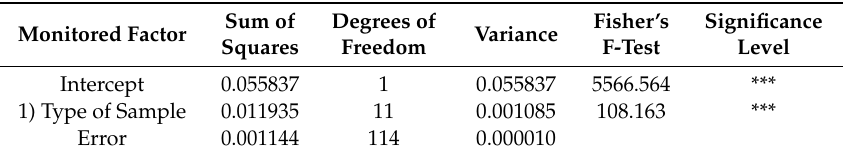
Table 6. Statistical evaluation of the e ff ect of the factors and their interaction on the coe ffi cient of wood bendability ( K bendC ) for beech and NWC on top.